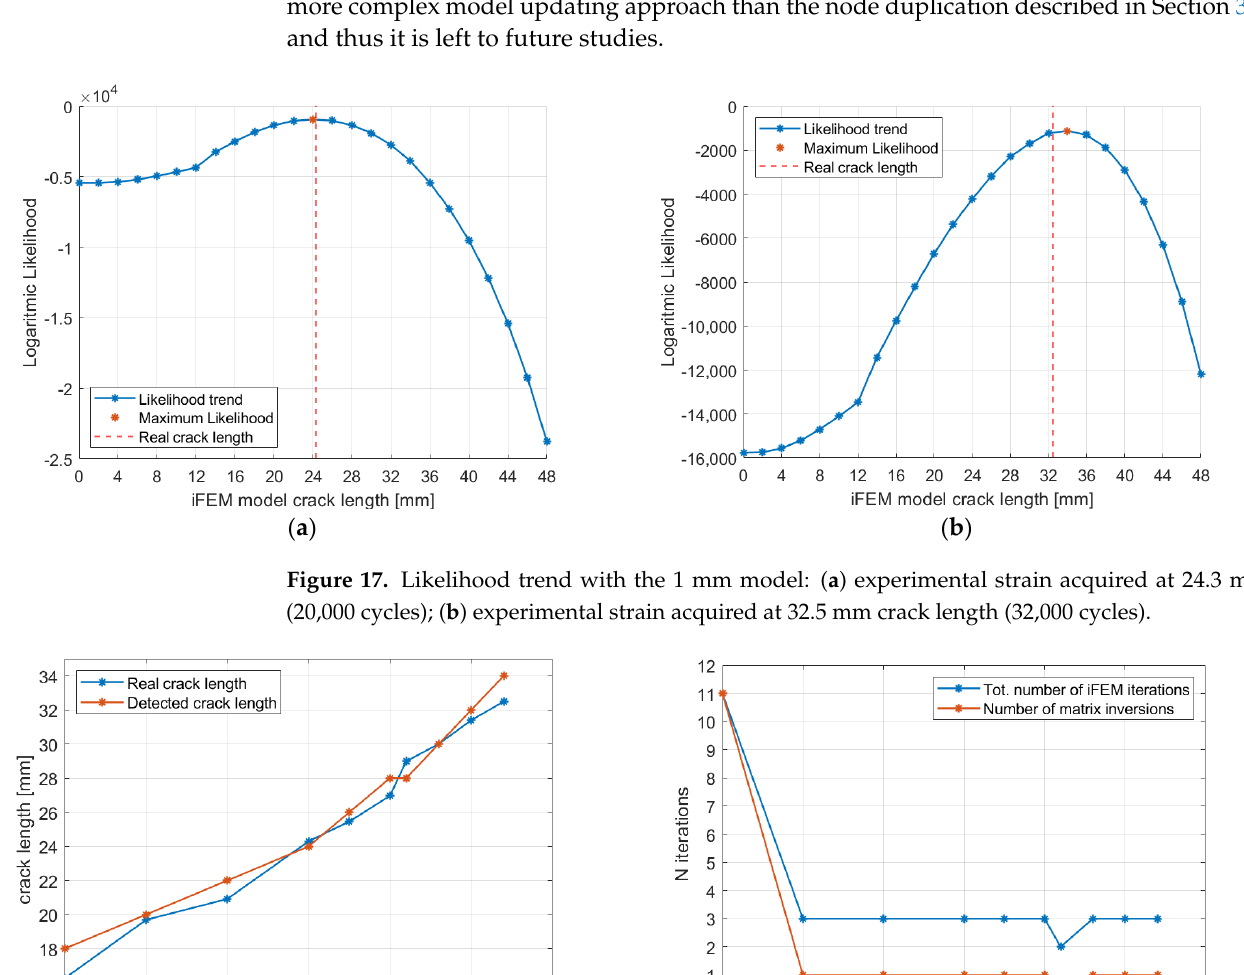
Figure 18. Crack size estimation routine results: ( a ) crack size estimated with respect to the target value of each acquisition; ( b ) the number of iFEM iterations and matrix inversions performed by the real-time algorithm.